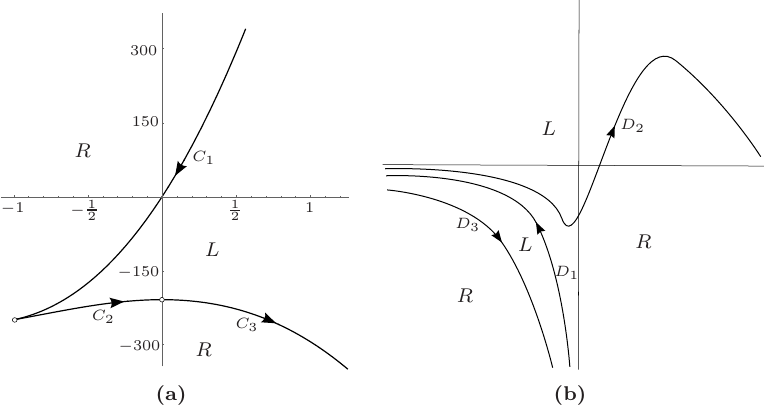
Figure 7 - The asymptotic variety of F in ( a ) and the asymptotic flower of F in ( b